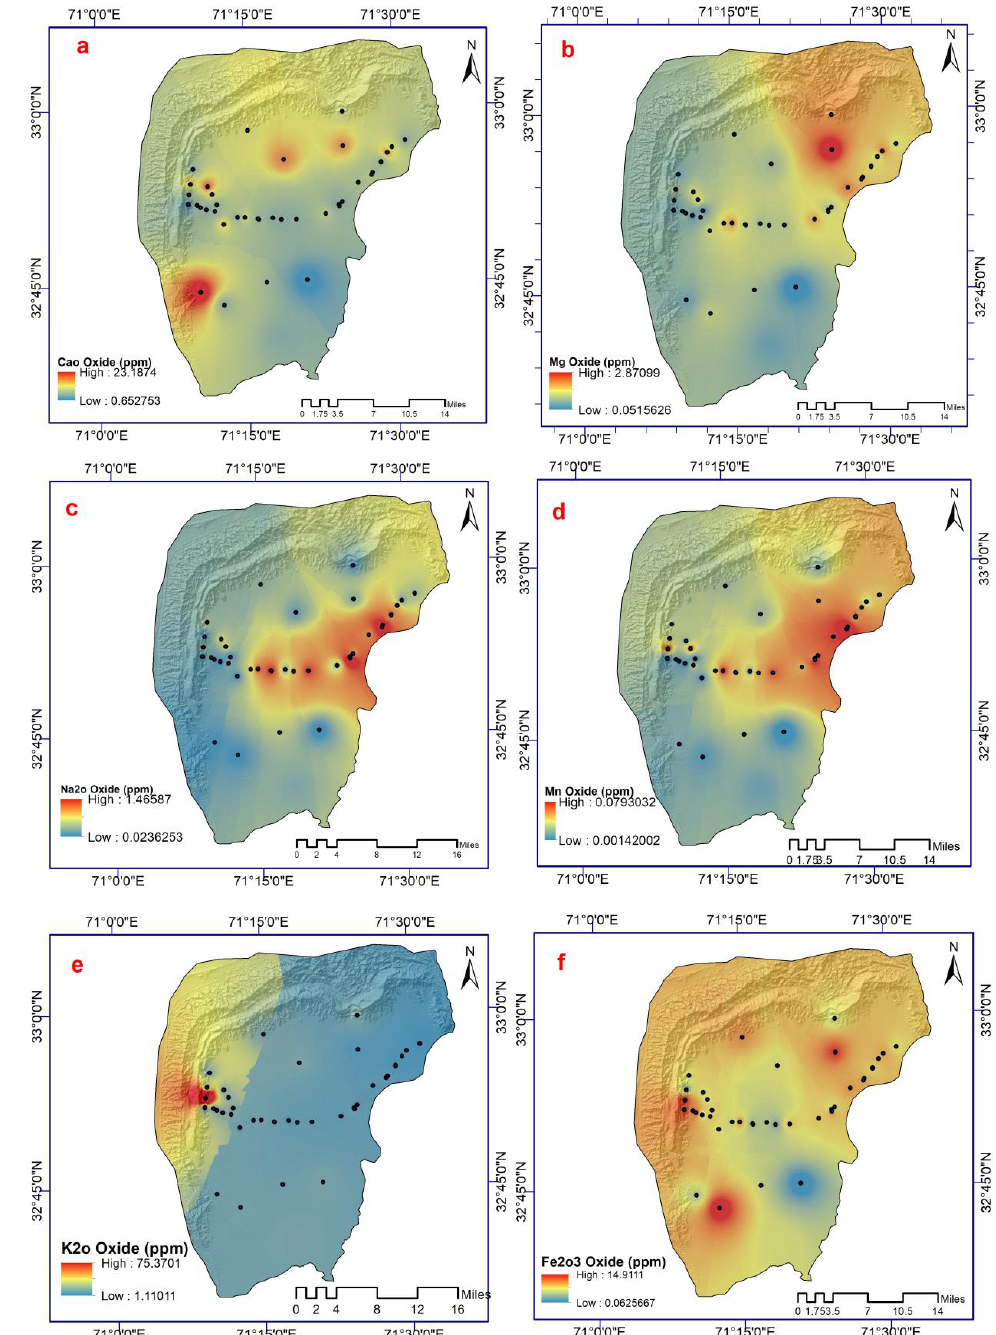
Figure 6. Concentration distribution maps of the major oxides ( a ) CaO, ( b ) MgO, ( c ) Na 2 O, ( d ) MnO, ( e ) K 2 O, ( f ) Fe 2 O 3 in the soil samples of the study area.